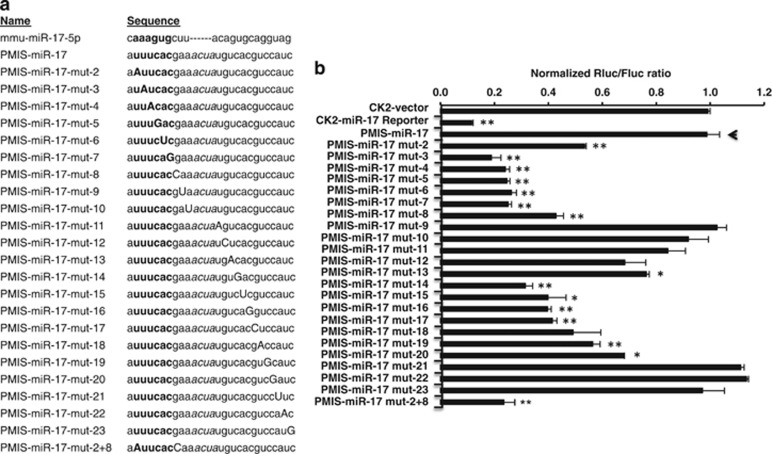
Specificity of miR inhibitors. (a) Sequence of miR-17 inhibitor and specific mutations to test function. The numbers indicate the mutated ribonucleotide (bold and in caps) and the AUCA sequence in the middle of the inhibitor sequence eliminates a perfect match.27 The seed sequence of the mature miR-17-5p is in bold as is the antisense sequence to the seed sequence in PMIS-miR-17. (b) Ribonucleotide mutation effects on miR inhibitor efficiency. Normalized Rluc to Fluc ratio of miR reporter vector without miR-17 binding site was set as 100%. The PMIS-miR-17 inhibitor mutants were co-transfected with miR reporter vector containing a miR-17 binding site into HEK 293FT cells. Rluc and Fluc activity was measured 48 h after transfection. T-test was performed against the sample, marked by arrow. *P<0.05 and **P<0.01.